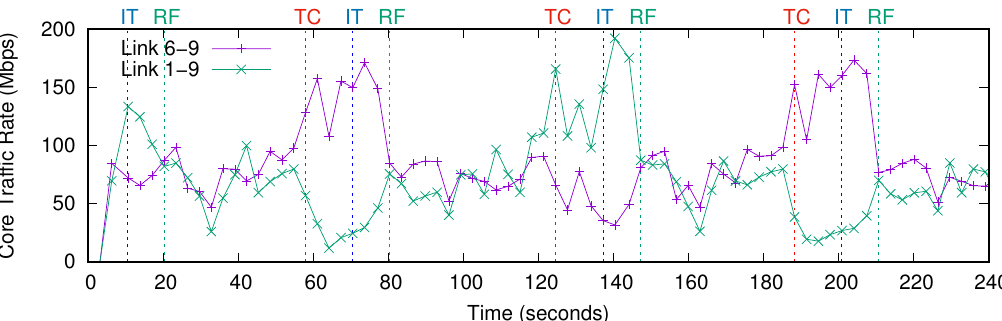
Figure 7. The edge link traffic rate statistics fetched by our application from OpenDaylight.